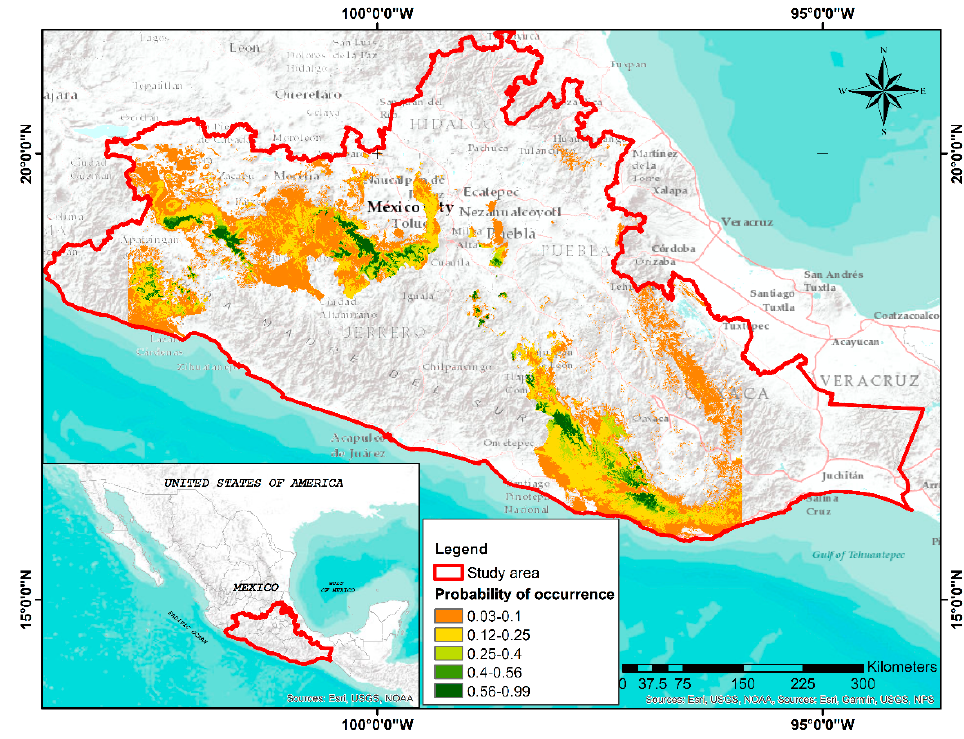
Figure 6. Potential spatial distribution of Pinus oocarpa using random forests.